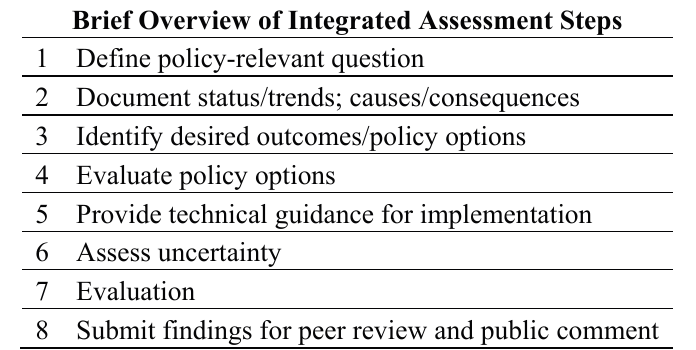
Table 2. Key steps of the integrated